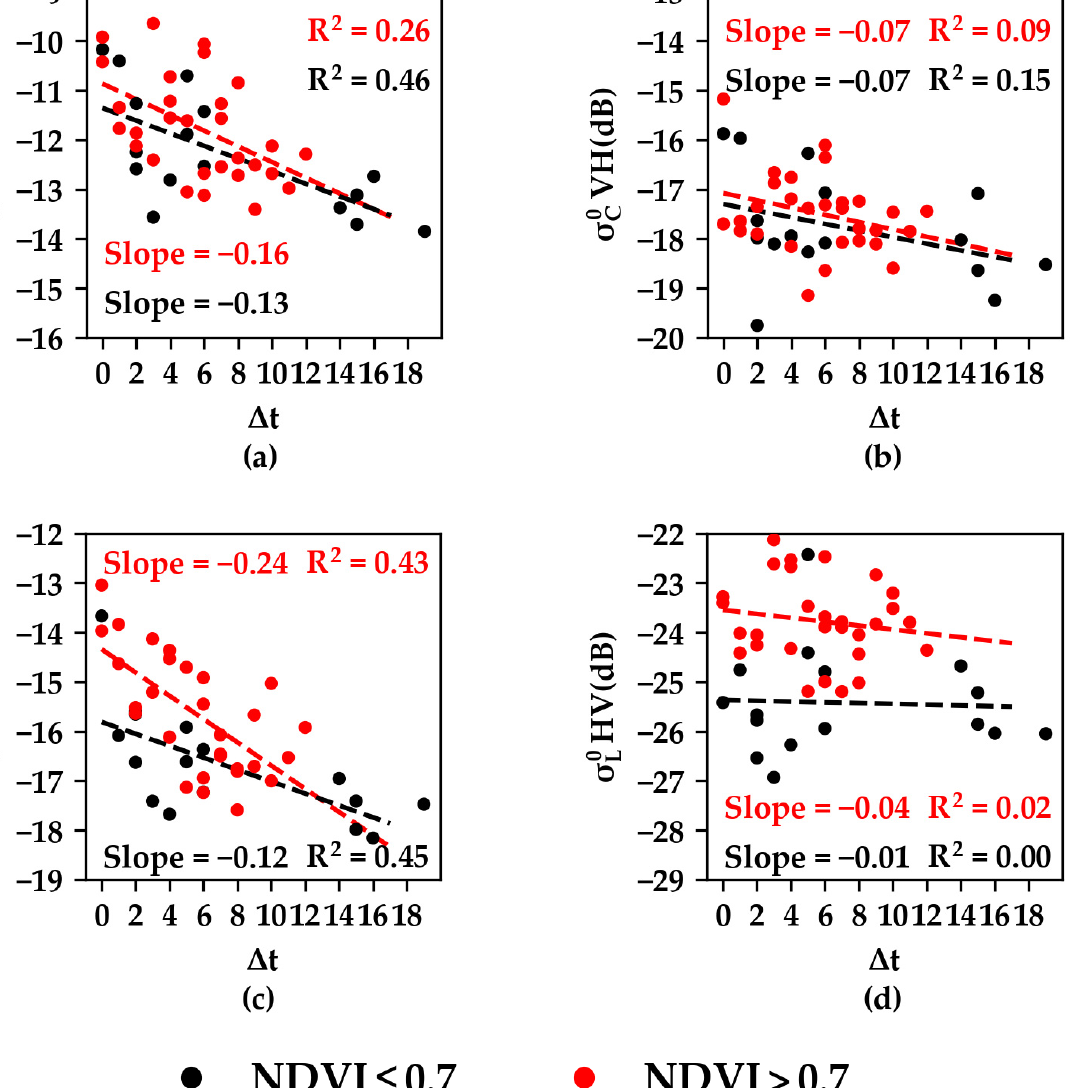
in VV, ( b ) σ 0 in C C